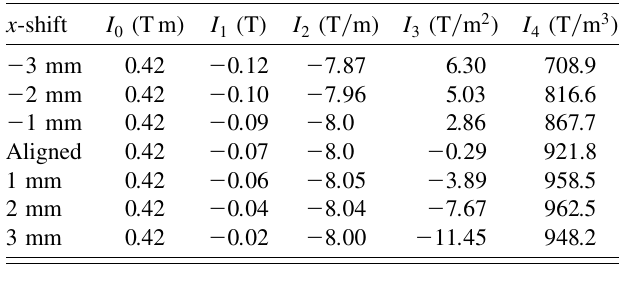
TABLE VIII. Definitive configuration (central semiperiod): integrated coefficients of the polynomial expansion of the mag- netic field.